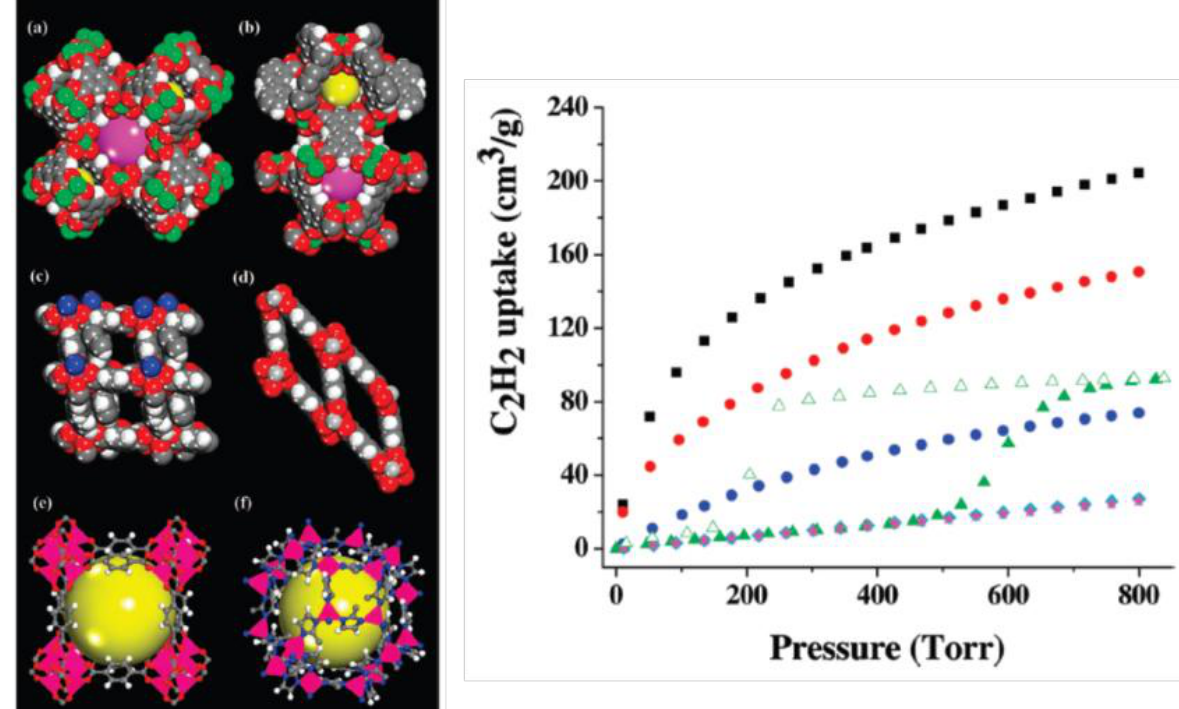
Figure 29. ( Left ) crystal structures of ( a ) HKUST-1; ( b ) MOF-505; ( c ) MOF-508; ( d ) MIL-53; ( e ) MOF-5; and ( f ) ZIF-8, in which ( a ) and ( b ) show open Cu 2+ sites (green). ( Right ) the C H adsorption isotherms of several MOFs, HKUST-1 (black); MOF-505 2 2 (red); MOF-508 (green); MIL-53 (blue); MOF-5 (cyan); and ZIF-8 (magenta). Reprinted with permission from [155]. Copyright 2009 American Chemical